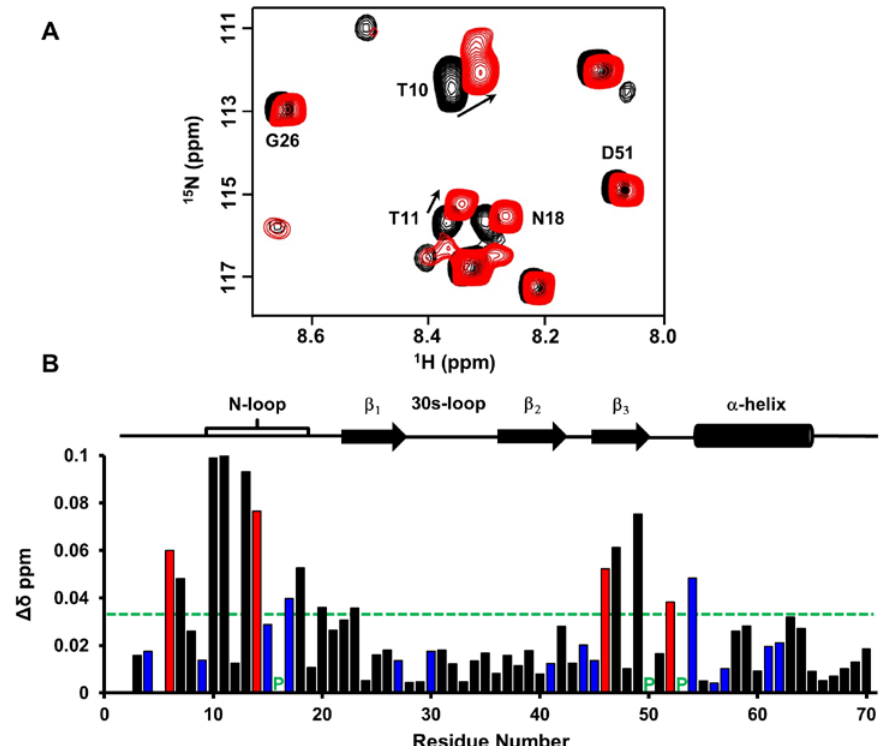
Figure 4. CXCL7 monomer binding to CXCR2 N-domain. ( A ) Portion of the 2D HSQC spectrum showing the overlay of CXCL7 in the free (back) and in the presence of CXCR2 N-domain at a 1:3.5 molar ratio (red). Residues showing significant perturbations are labeled and arrows indicate the direction of the peak movement; ( B ) Histogram plot of binding-induced chemical shift changes in the CXCL7 monomer as a function of amino acid sequence. Basic residues are shown in blue. Hydrophobic residues with significant CSP are shown in red. Prolines are indicated by a green ‘P’. Residues that show CSP above the threshold (dashed line) are considered involved in binding. Secondary structural elements are given for reference.